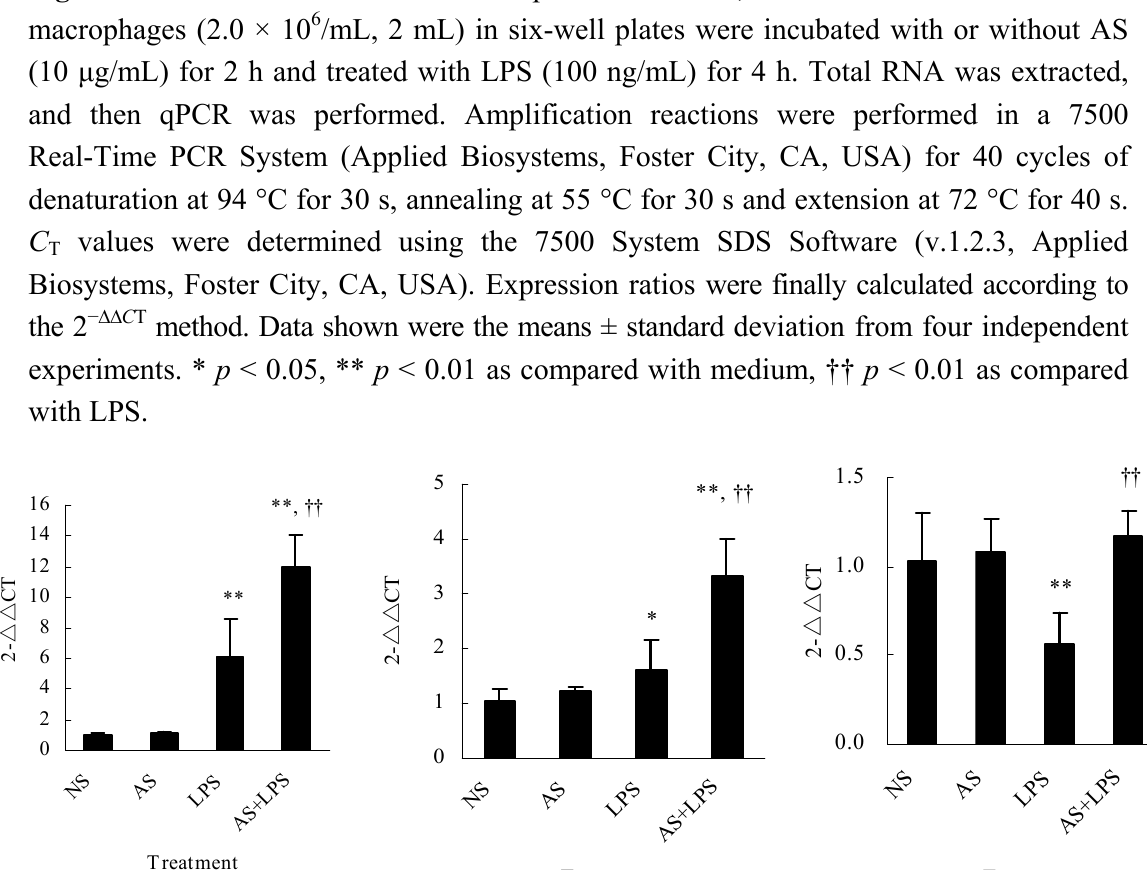
Figure 8. Influences of AS on mRNA expression of SR-A , MARCO and SR-BI . Peritoneal macrophages (2.0 × 10 6 /mL, 2 mL) in six-well plates were incubated with or without AS (10 μ g/mL) for 2 h and treated with LPS (100 ng/mL) for 4 h. Total RNA was